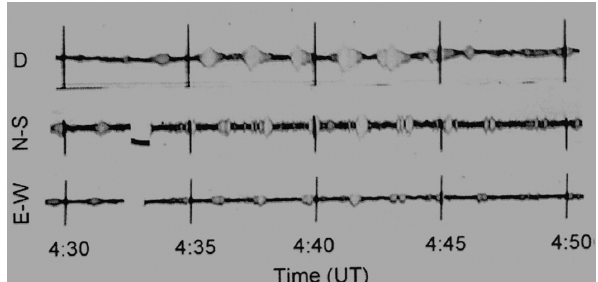
Figure 10. Geomagnetic pulsation registered at SGO on 6 Febru- ary 1935. Especially in the D component, the repetitive occurrence of pearls are discernible, which gave rise to the term Pc1 pearl geo- magnetic pulsations (see Kangas and Raita,